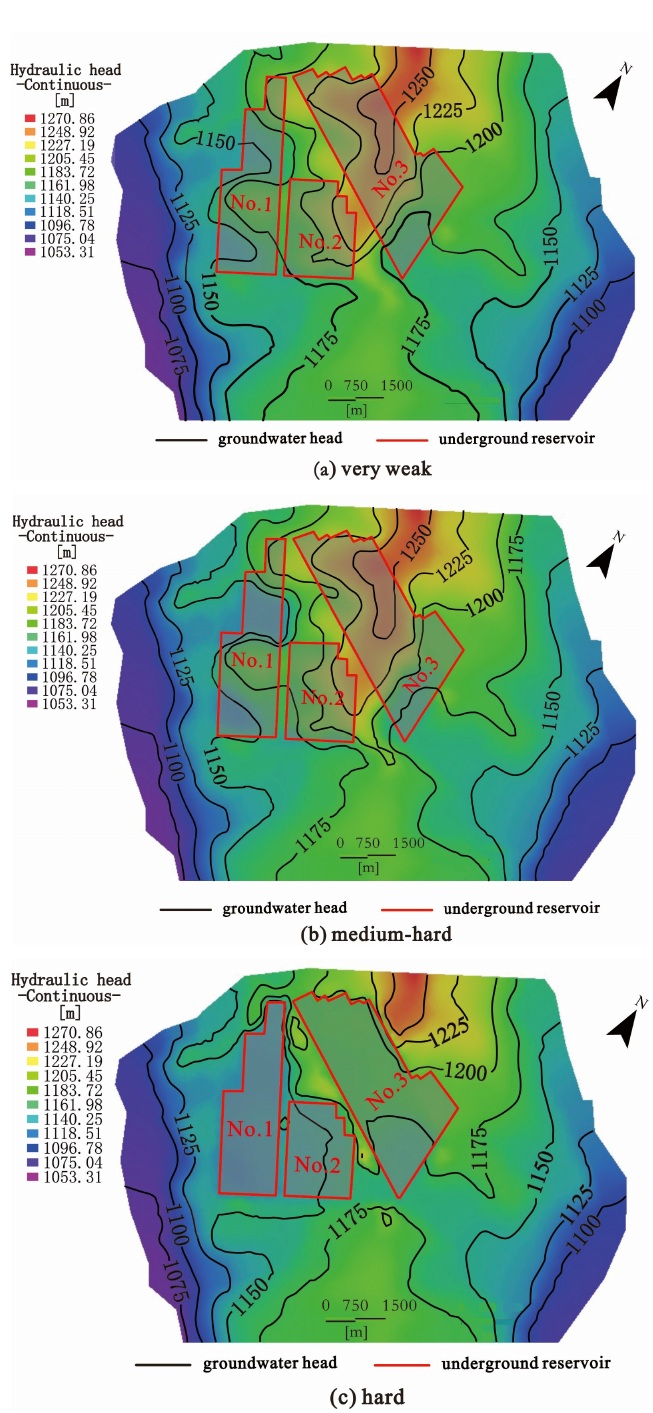
Figure 11. Groundwater contour map of the upper aquifer system under different lithologies of overlying strata: ( a ) very weak, ( b ) medium-hard, ( c ) hard.